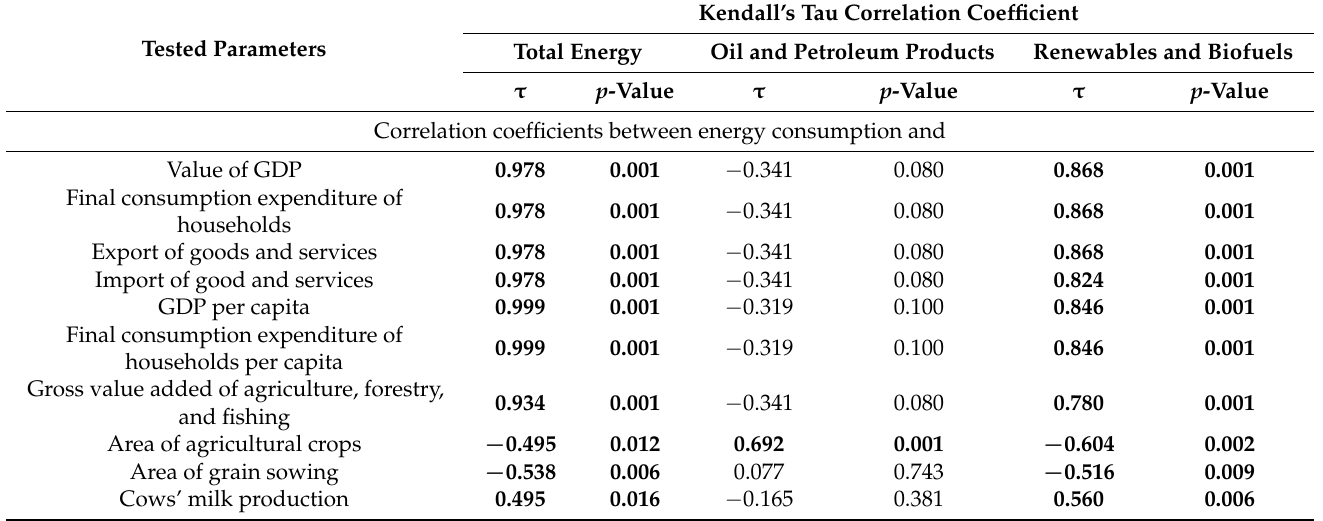
Table 4. Kendall’s tau correlation coefficients between the volume of use of energy in agriculture in the EU countries and the parameters of the economy and